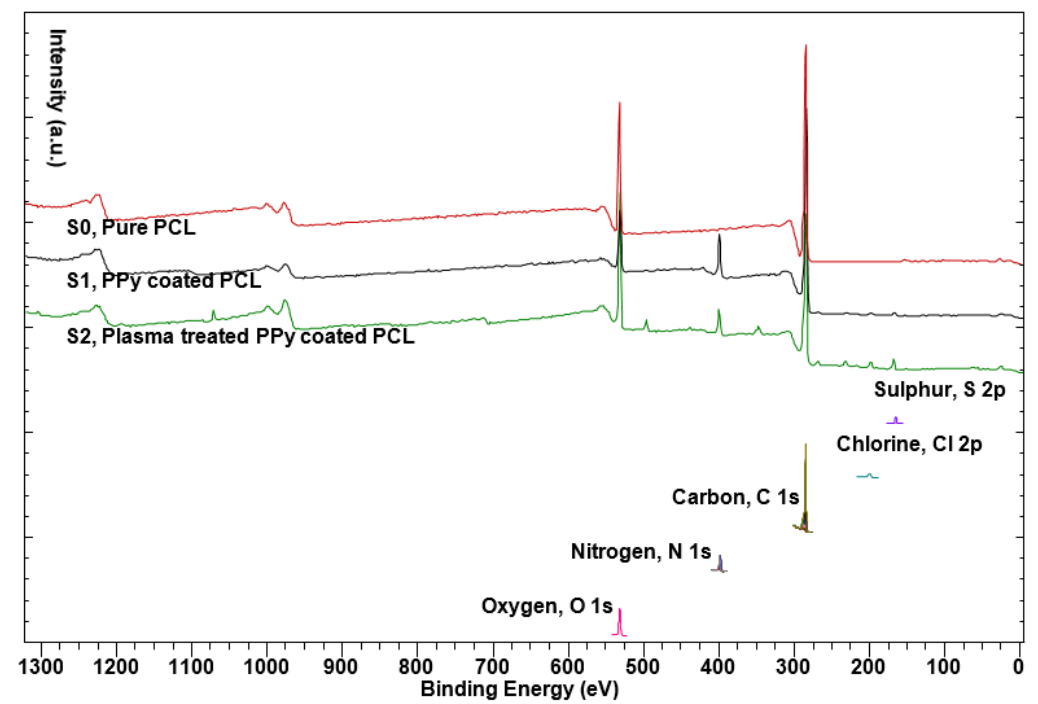
Figure 4. XPS wide spectra for PCL, PPy-coated PCL without and with plasma treatment. Nitrogen, chlorine and sulphur peaks are available for the coated samples. There is some contamination of plasma-treated sample, which is expected to be due to the contamination of the plasma chamber.